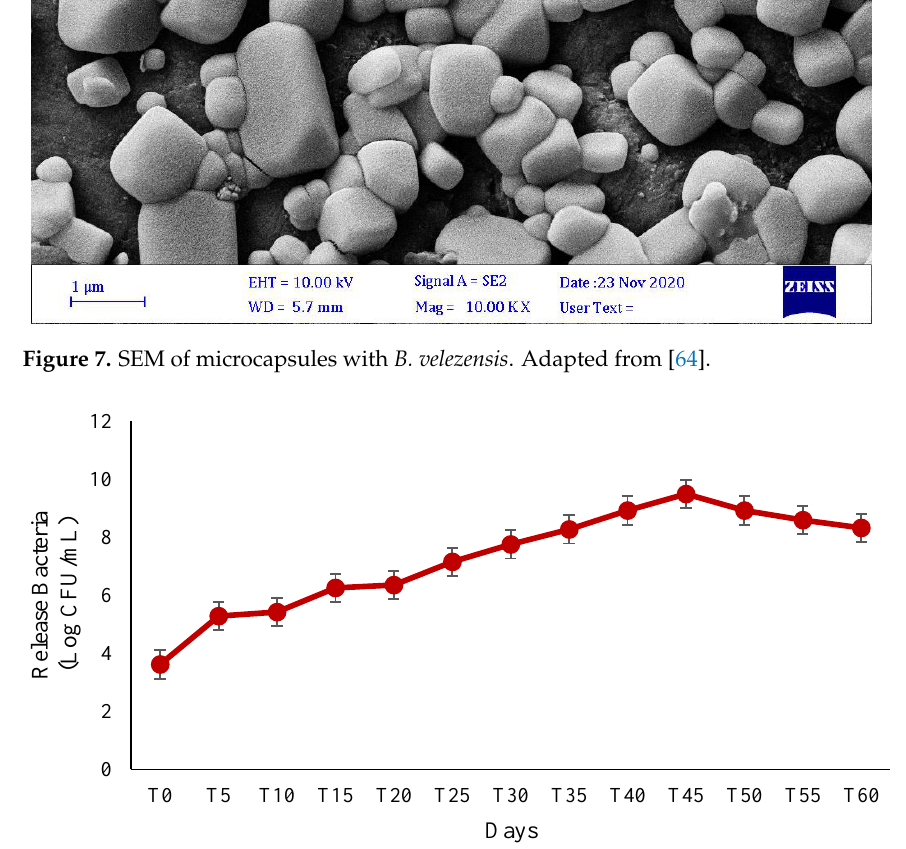
Figure 8. Release of B. velezensis from microcapsules prepared with ALG and gelatin.